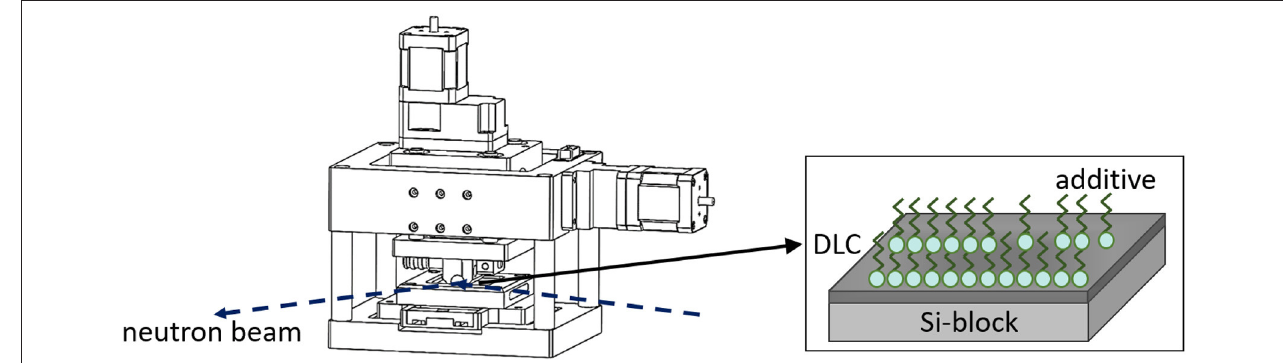
FIGURE 2 | Schematic of the test rig implemented in the neutron reflectometer.